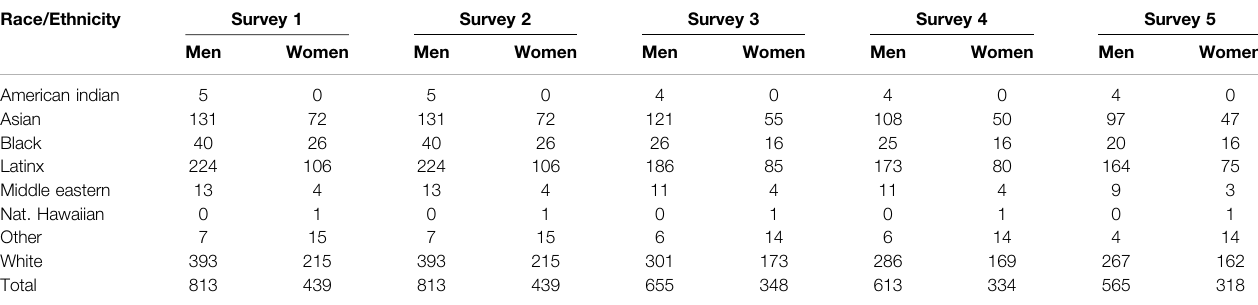
TABLE 3 | Respondent Race/Ethnicity by Gender for Surveys 1, 2, 3, 4, and 5.